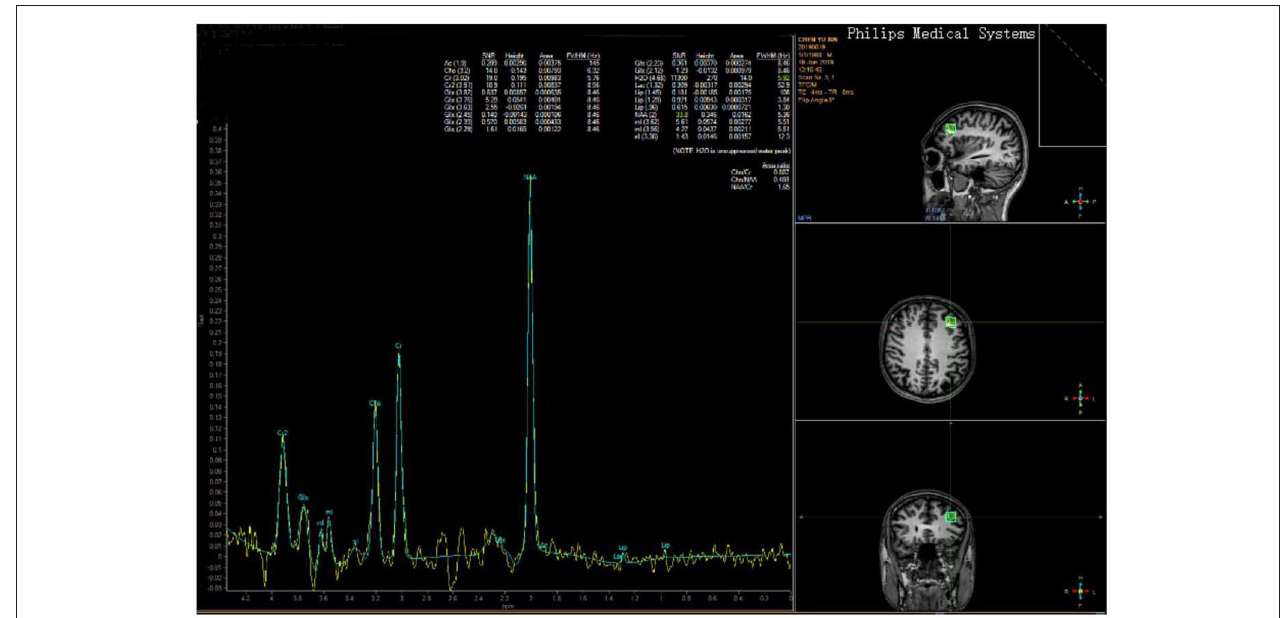
FIGURE 2 | A single voxel was placed in the left DLPFC (in BA 46, shown at right). A typical spectrum from this voxel is shown on the left and demonstrates metabolite peaks for N-acetyl-aspartate (NAA), choline (Cho), and creatine (Cr), which have been implicated in the pathophysiology of